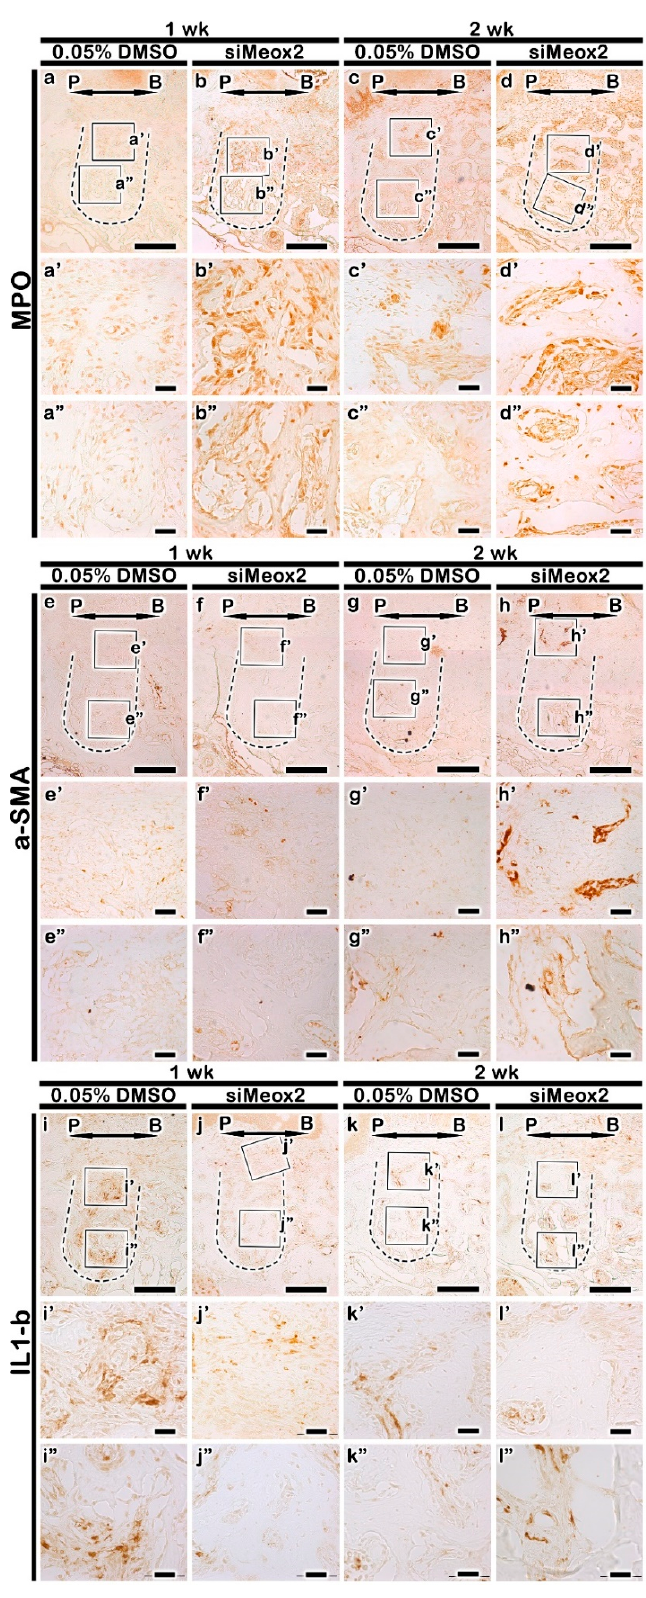
Figure 5. Immunolocalization of Myeloperoxidase (MPO) ( a – d ), alpha- Smooth muscle actin ( α -SMA) ( e – h ) and Interleukin 1 beta (Il-1 β ) ( i – l ). The number of MPO positive cells is higher in si Meox2 treated specimens ( a ) than in carrier control ( b ) at 1 week. After 2 weeks of treatment, the number of MPO